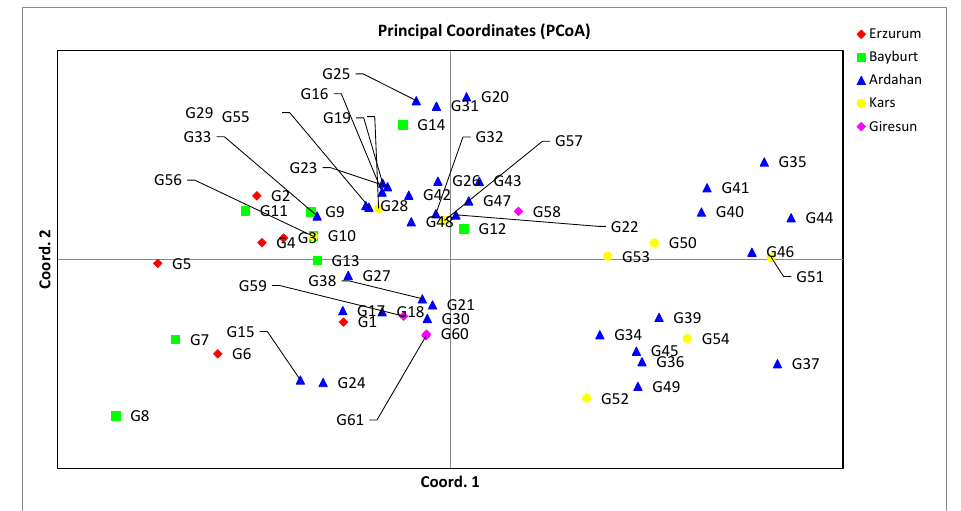
Figure 3. PCoA of forage pea ( P. sativum ssp. arvense L.) landrace accessions. 3.3. Population Structure among 61 Forage Peas (P. sativum ssp. arvense L.) Landrace Accessions Using SSR Table 5. PCoA analysis of forage pea ( P. sativum ssp. arvense L.) landrace